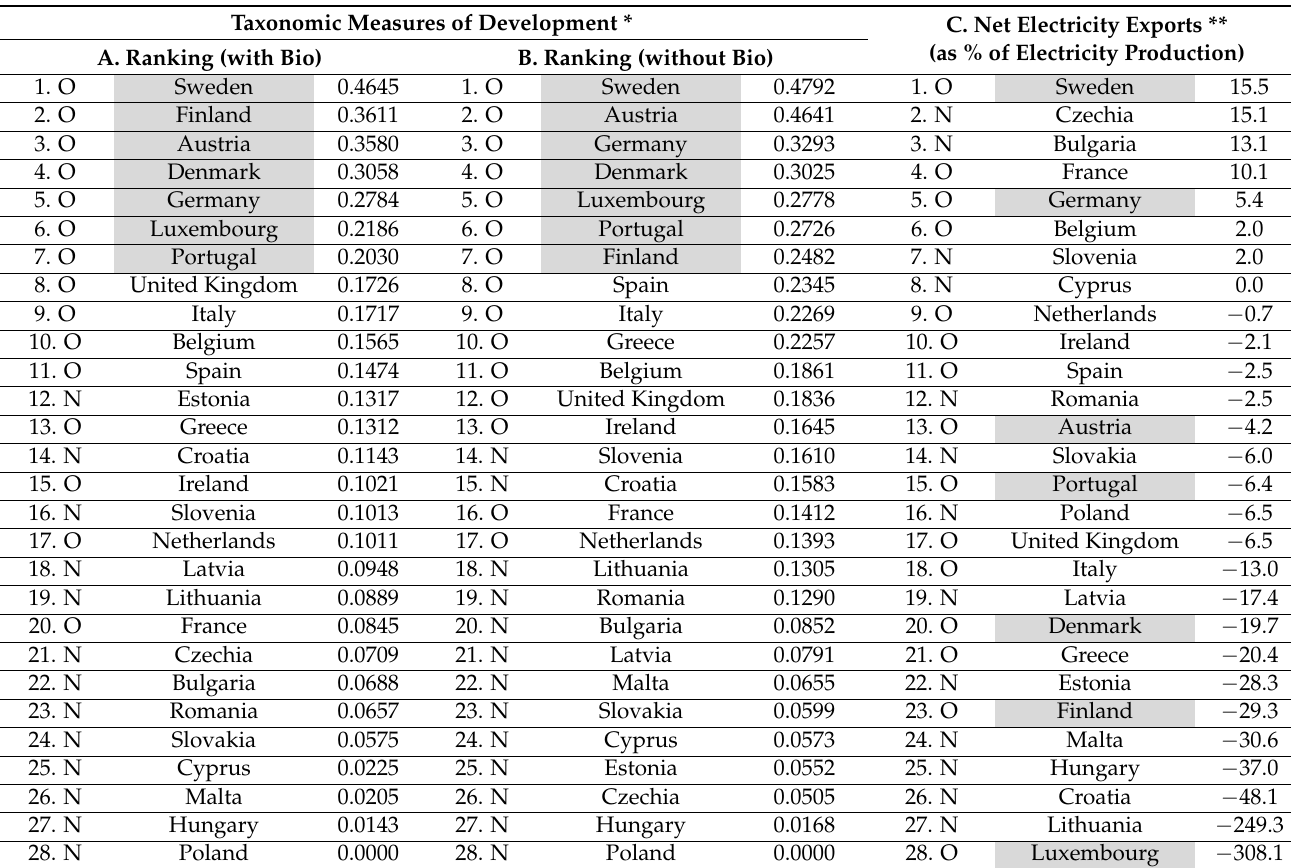
Table 2. Taxonomic measures of development of renewable electricity generation in EU countries and net electricity exports—country rankings for